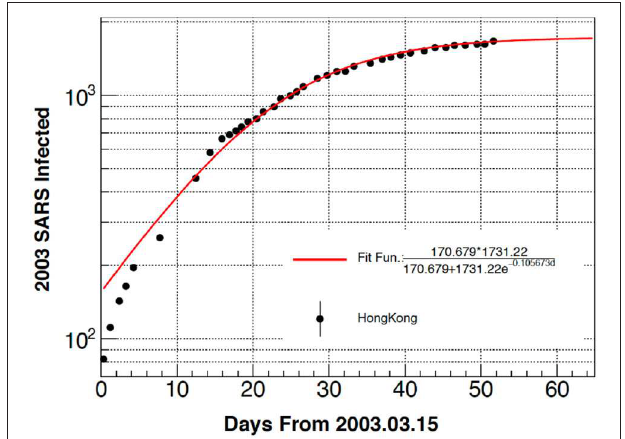
FIGURE 3 | Same as Figure 2 for the different countries indicated in the inset. The South Korea and Iran cases seem to reach the saturation value, suggesting that the epidemic is saturating. If this is confirmed, it suggests that the crisis is saturating within 15 days either due to government actions or the particular conditions (weather, average temperature, density of population, etc). The Japan case is not close to the saturation value, thus we had to force d ∞ to a finite value to perform the